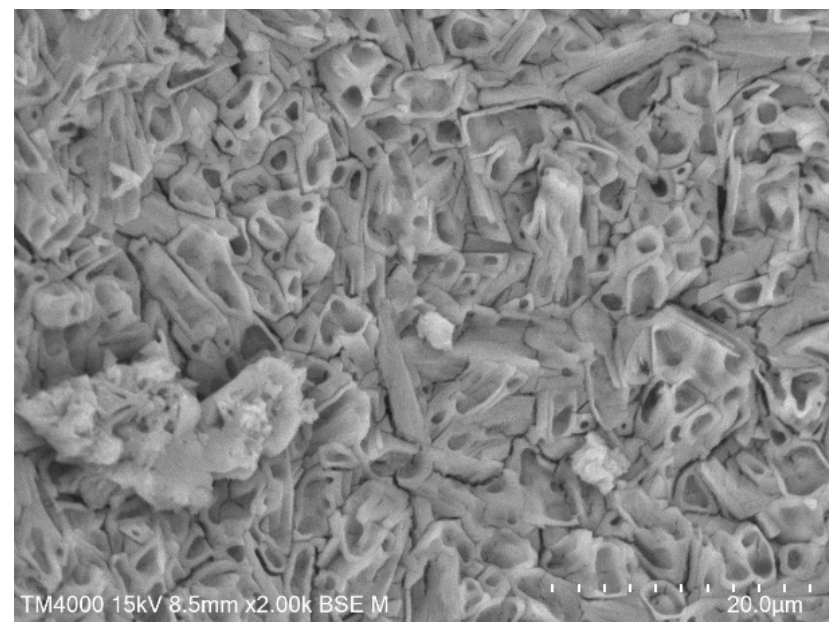
Figure 17. SEM micrographs of MPC with 20% BA at 28 days.